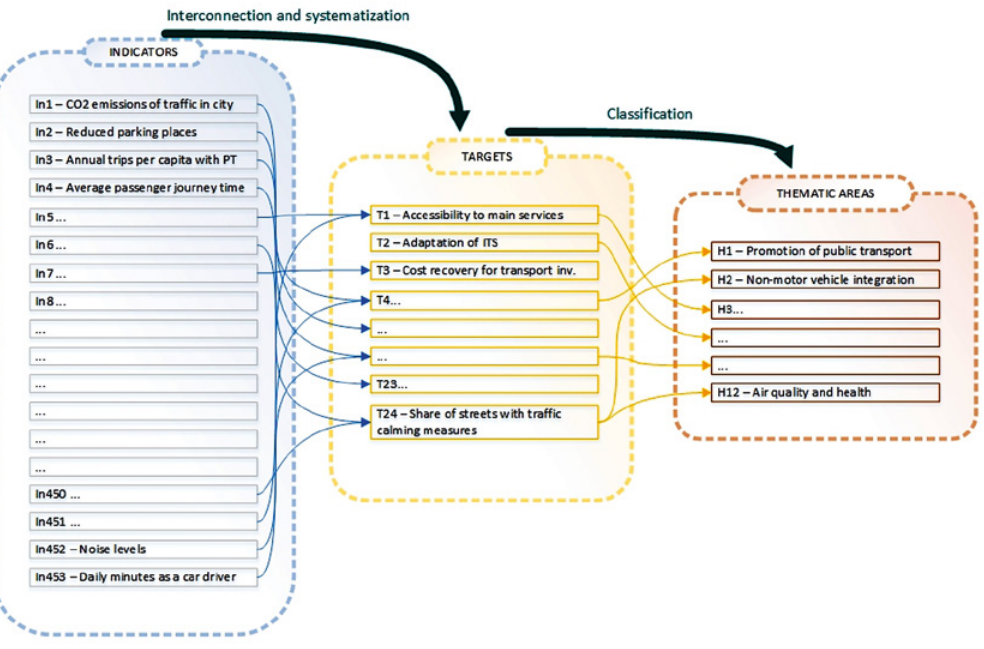
Figure 2. The principal scheme for the structure of Sustainable Urban Mobility Plans evaluation indicators and